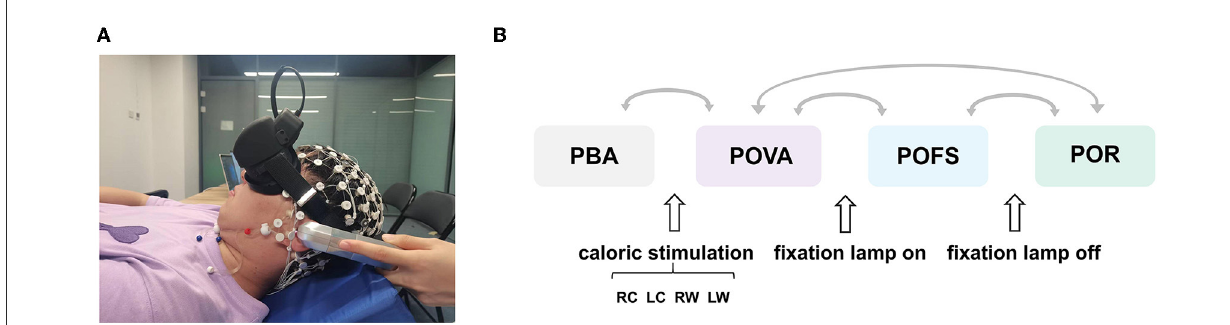
FIGURE1 Schematic diagram of the experiment. (A) Experimental setup. (B) Schematic diagram of the overall experimental flow. The two phases connected by each arrow were compared. PBA refers to the phase before activation, POVA refers to the phase of vestibular activation, POFS refers to the phase of fixation suppression, and POR refers to the phase of removing fixation suppression, respectively. RC, LC, RW, and LW are the abbreviations of right cool, left cool, right warm, and left warm, respectively.